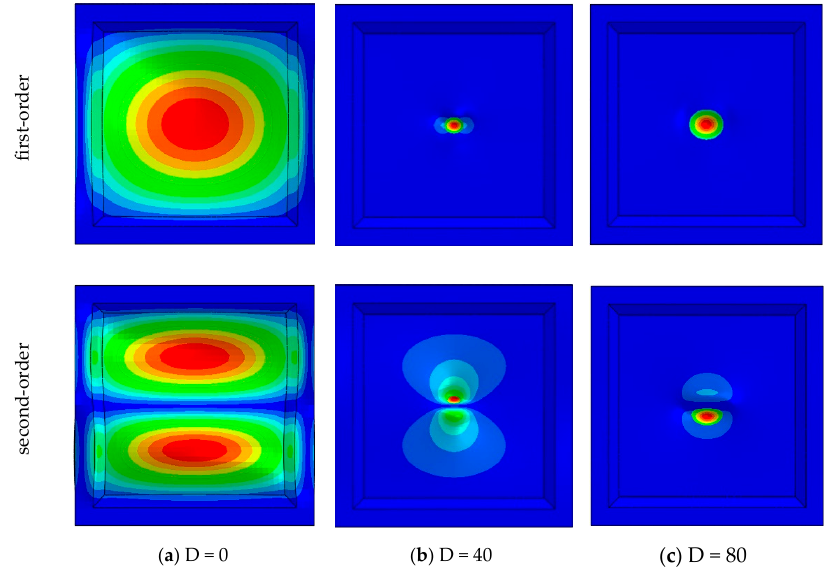
Figure 15. Buckling modes of di ff erent honeycomb panels. ( a ) the first-order and second-order buckling modes of non-defective specimens; ( b ) the first-order and second-order buckling modes of specimens with defective diameter 40 mm; ( c ) the first-order and second-order buckling modes of specimens with defective diameter 80